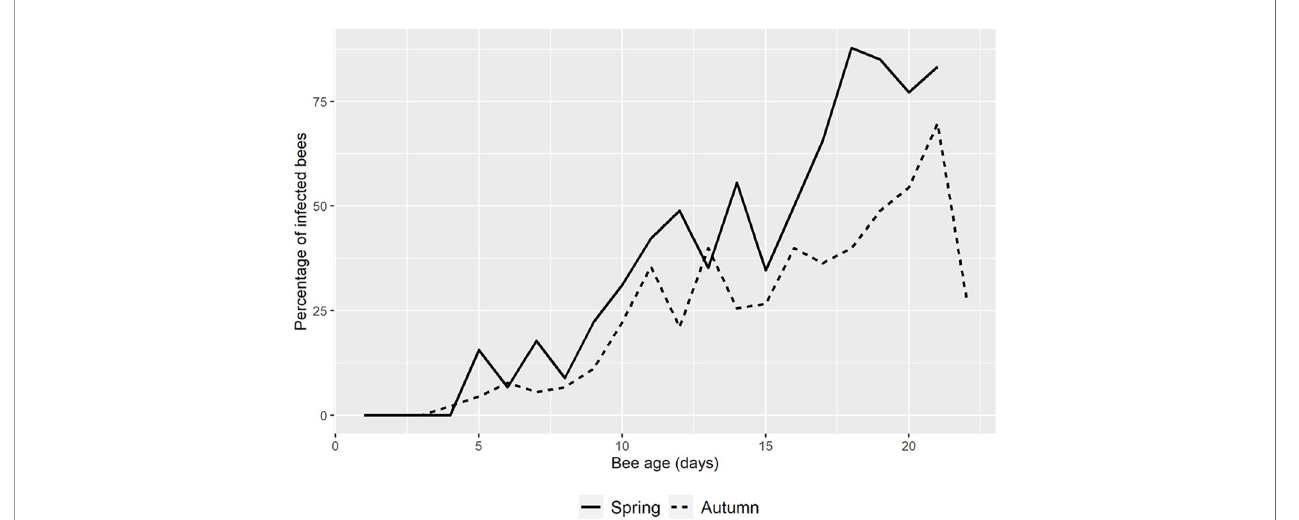
FIGURE 2 | Mean percentage of N. ceranae in spring and autumn. The percentage in spring (solid line) starts one day later than in autumn (dotted line) and it remains higher except on days 6 and 13 p.e. On the last day of autumn, the percentage of infection drops